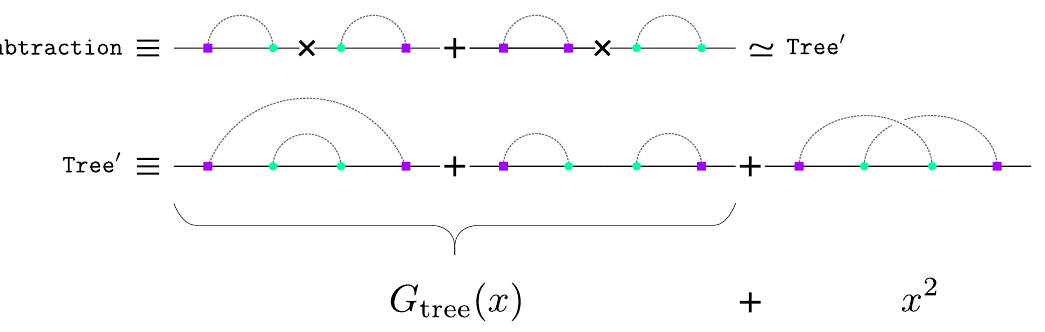
Figure 6 . Here we illustrate schematically some terms appearing in the calculation (with purple squares ' fixed variables, and green circles ' integrated variables). The term Tree 0 is given by the tree-level 4-point function, integrated in the two middle variables, plus an extra term given by two propagators crossed in a non-planar fashion. Superficially, these terms have the same form as the terms of the Subtraction , which are also given in the first line in terms of products of integrated 2-point functions integrated in some of the variables. The only mismatch comes from the range of the integrated variables, cf. (C.36) vs (C.38). The tiny (cid:15) -dependent mismatch, combined with the divergence of the integrals, produces a finite result in our calculation, cf.